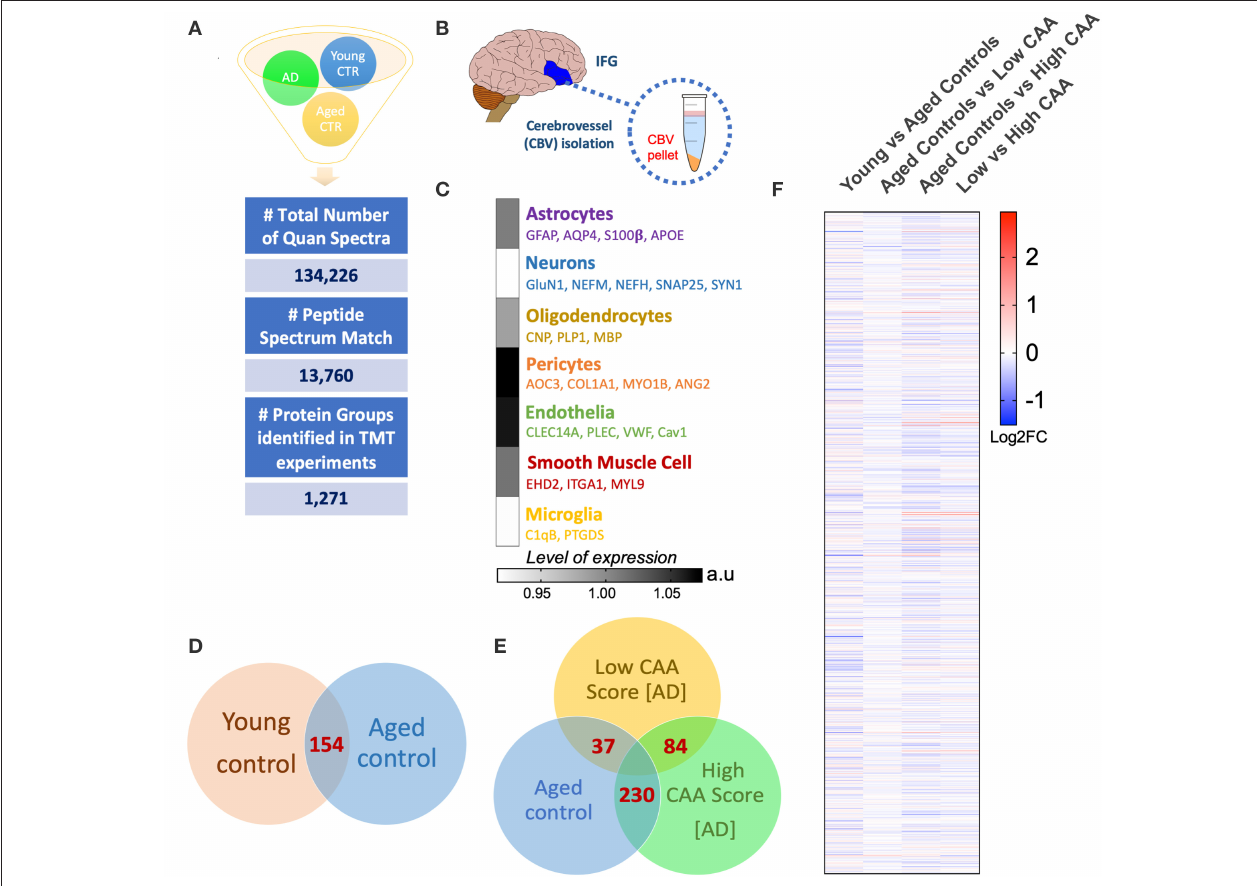
FIGURE 2 | Summary of liquid chromatography/mass spectrometry (LC/MS) and proteomic analyses of isolated cerebrovascular tissue from the inferior frontal gyrus in Alzheimer’s disease (AD) and young/aged matched control cases. (A) Shows identified total number of quantified spectra, peptide spectrum matches and non-redundant master protein groups from all plexes used for quantitative proteomic analyses of (B) isolated cerebrovascular tissue from the inferior frontal gyrus [IFG]. (C) Data shows expression levels of distinct genes associated with specific cell types identified from our proteomic analyses of the isolated cerebrovasculature. Data represent abundant ratio expressed in arbitrary units. Venn diagram in (D,E) shows overlapping significantly regulated proteins by t -test in the comparisons between young vs. aged healthy controls cases and Low CAA vs. High CAA vs. Age-matched controls, respectively. (F) Shows heat map of proteins identified from our proteomic analyses between young vs. aged controls, aged control vs. low CAA, aged controls vs. high CAA and low vs. high CAA groups (data represent Log2 fold change).